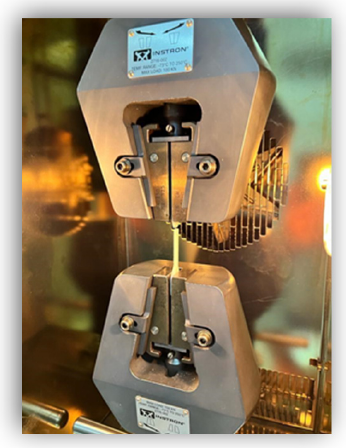
Figure 7. Samples and Instron testing machine.